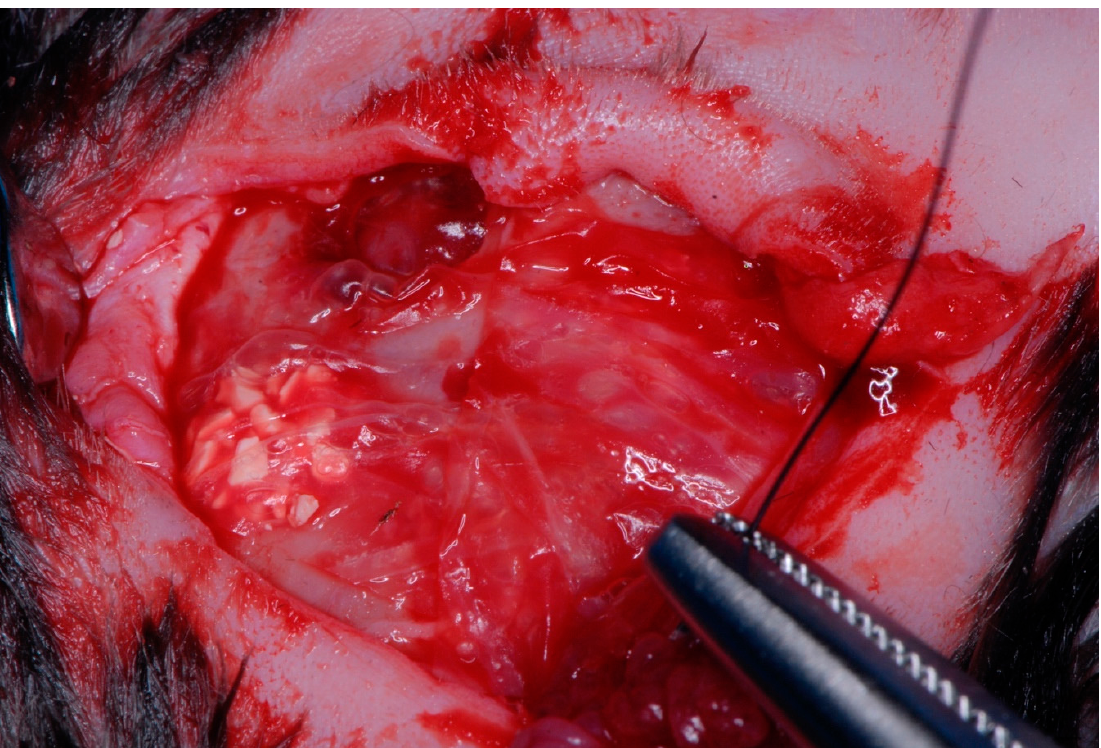
Figure 2. The three different materials and control gap. Materials 2019 , 12 , x FOR PEER REVIEW